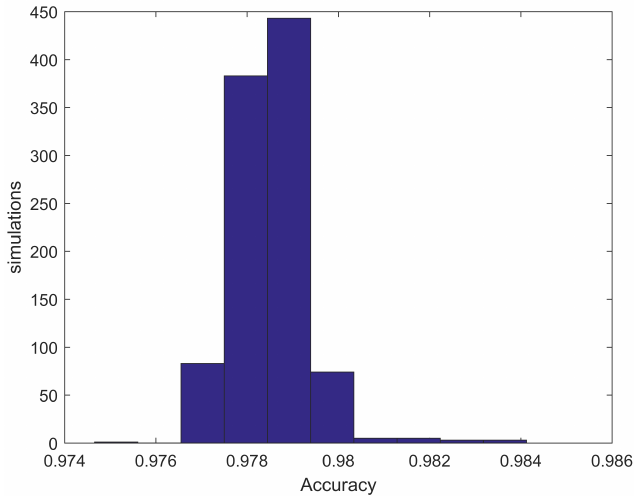
Figure 5. Histogram of the accuracy obtained in 1000